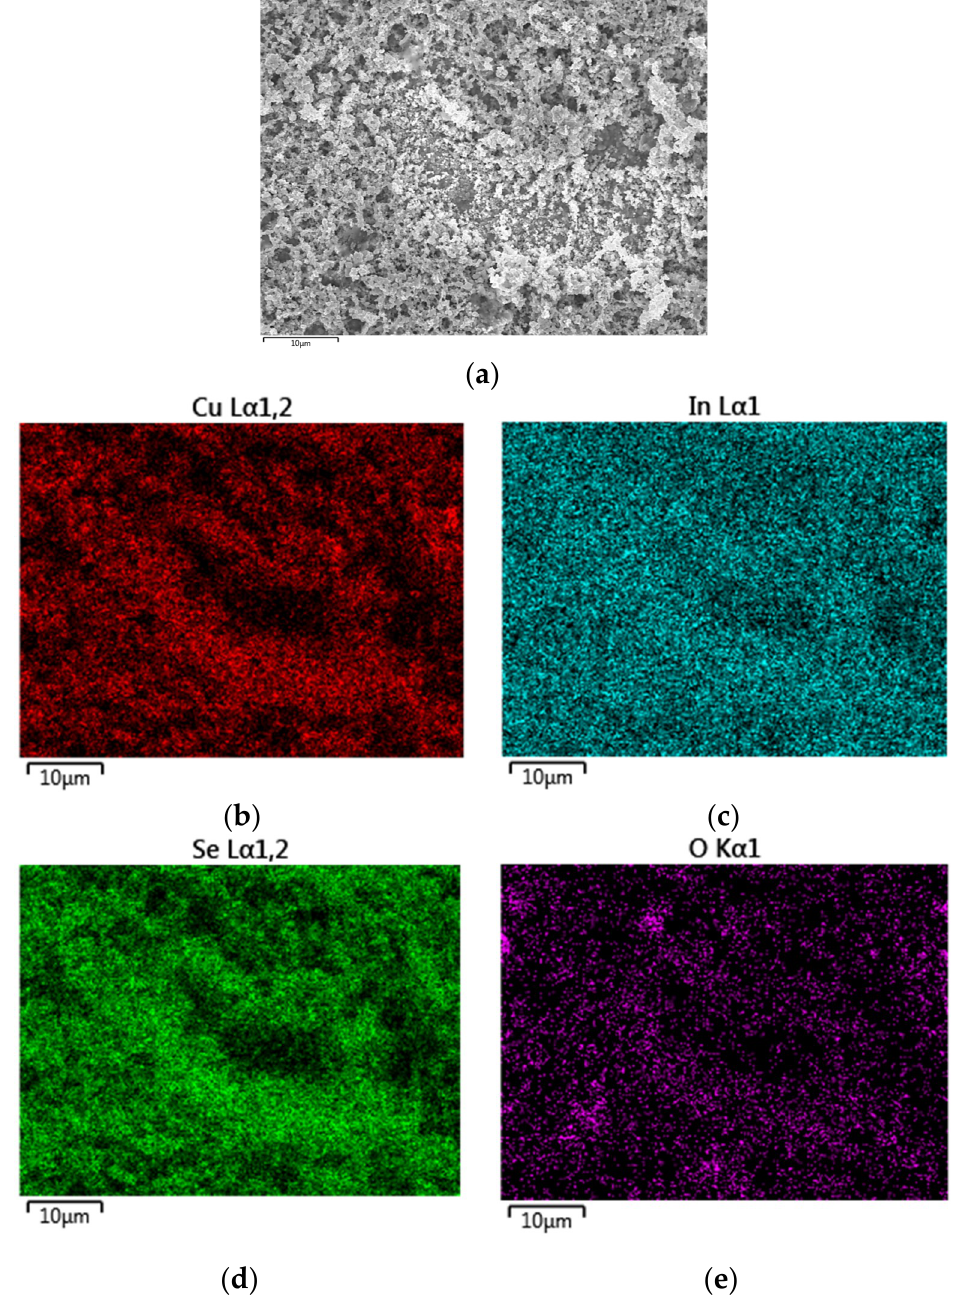
Figure A3. Energy dispersive X-ray spectroscopy (EDX) mapping ( a ) of route Ib CISe film with an elemental composition of Cu: 24.7 at % ( b ); In: 22.8 at % ( c ); Se: 46.7 at % ( d ); O: 3.9 at % ( e